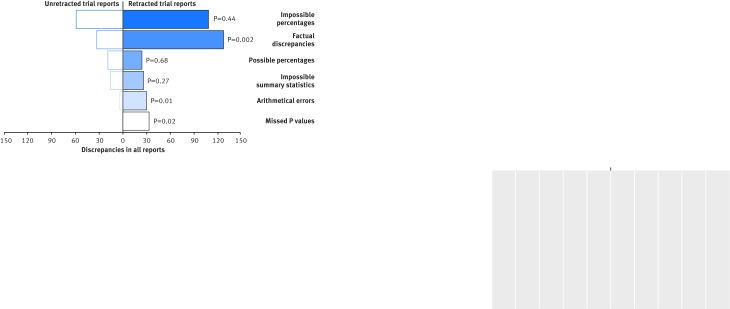
Fig 2 Total number of discrepancies by type across all 100 trial reports. Each bar represents the total number of one type of discrepancy in 50 trial reports. On the left are those found in unretracted control reports. On the right are those found in retracted reports